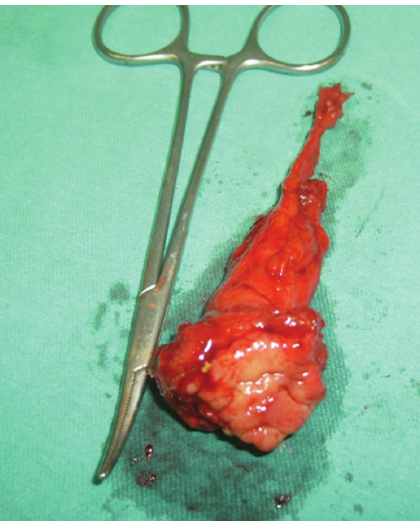
Figure 2: Partial cystectomy plus en bloc resection of the urachus.